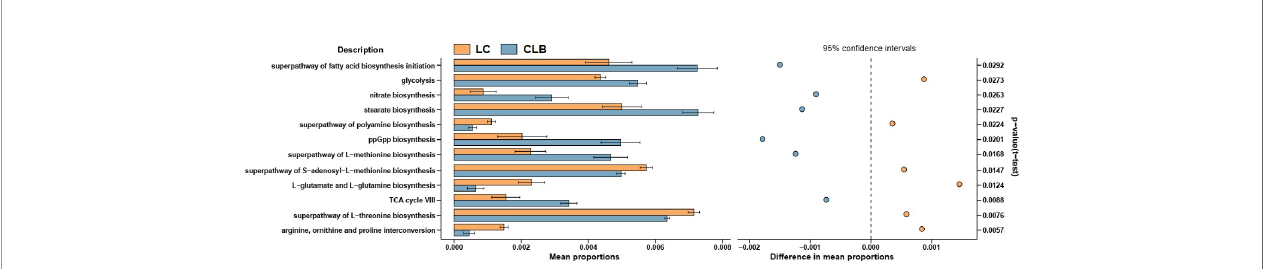
FIGURE 7 | Function alterations of the lung microbiota between patients with lung cancer only (LC) and patients with both COPD and lung cancer (CLB). Microbial gene functions were predicted by using the